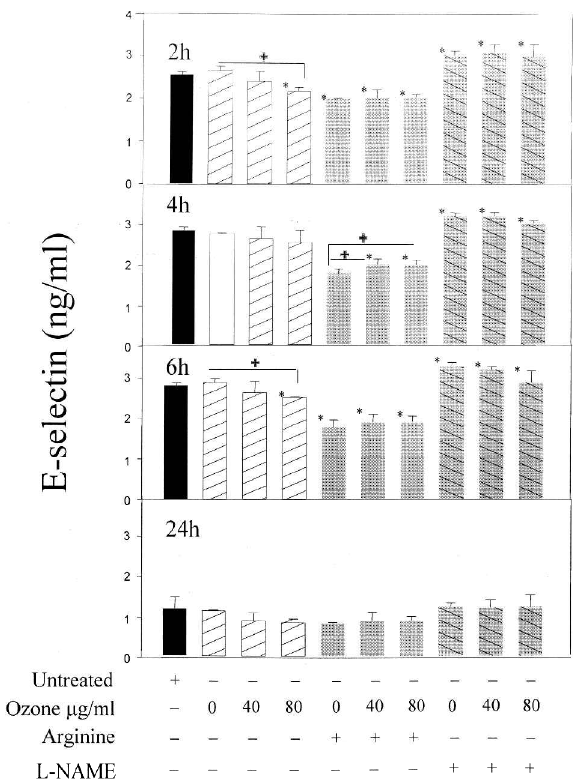
FIG. 5. Kinetics of release of E-selectin from HUVECs after addition of human serum either after oxygenation or after ozonation. Effect of the addition of L-arginine and L-NAME. The data are presented as the arithmetic mean ±SD of 6 different